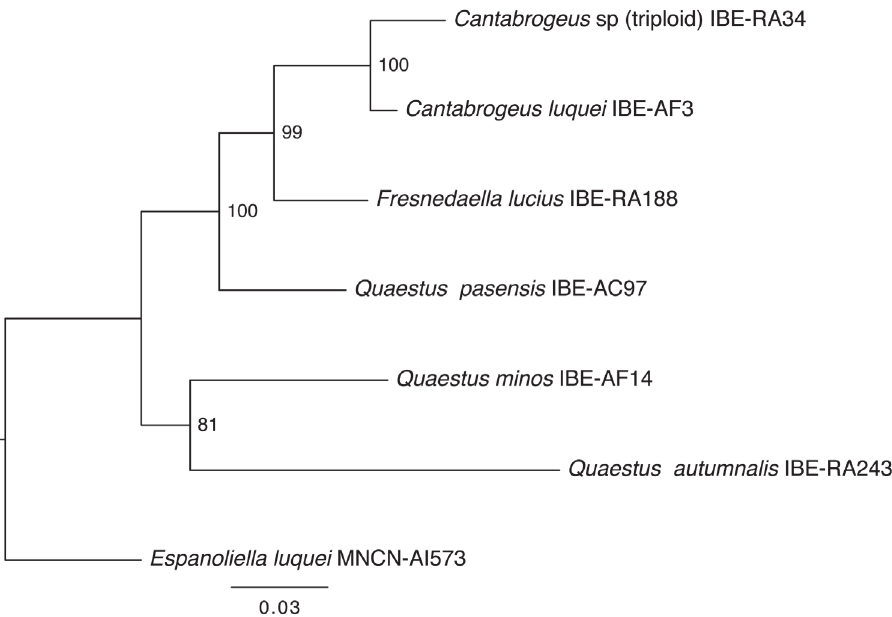
Figure 6. Phylogenetic relationships of triploid Cantabrogeus sp., obtained with the same genes and methodology used by Ribera et al. (2010). Courtesy of I. Ribera, Institute of Evolutionary Biology, CSIC– UPF (Barcelona,